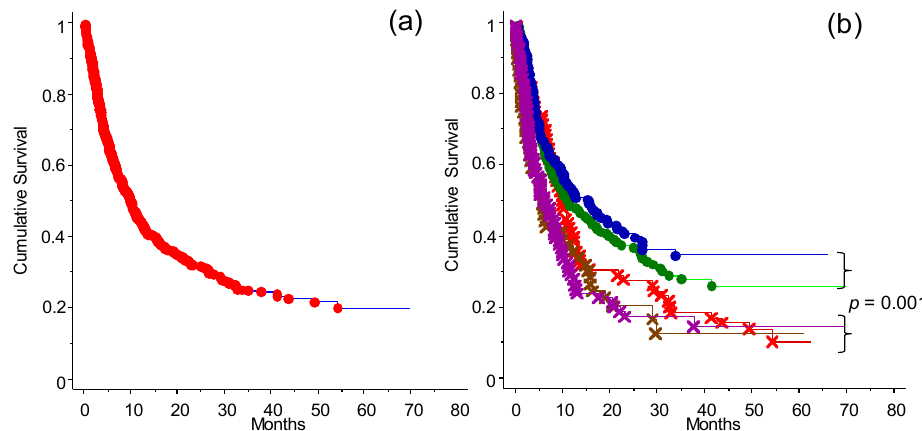
Figure 2. Cumulative survival analysis of patients depending on treatment before enrollment to the ICI program at the INT-NA: ( a ) Survival curve for the whole cohort of patients ( n = 578). ( b ) Survival analysis of patients stratified into five groups based on treatment received before access to the INT-NA’s program: naïve (blue line); immunotherapy (green line), cytostatic (red line), immunotherapy and target treatment (brown line), and target treatment (purple line). Naïve and immunotherapy groups (non-target) had an OS significant higher compared to the other treatment groups ( p = 0.001) (see also Figure 4a).